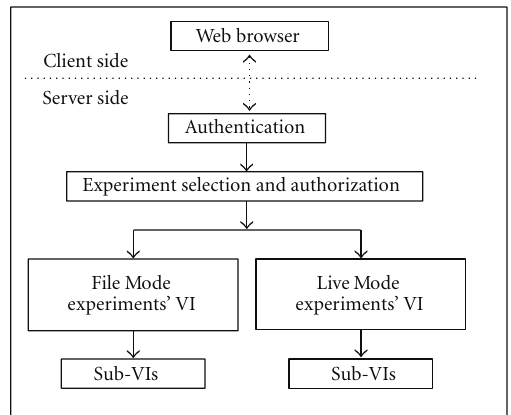
Figure 3: Software block diagram of web-based experimental